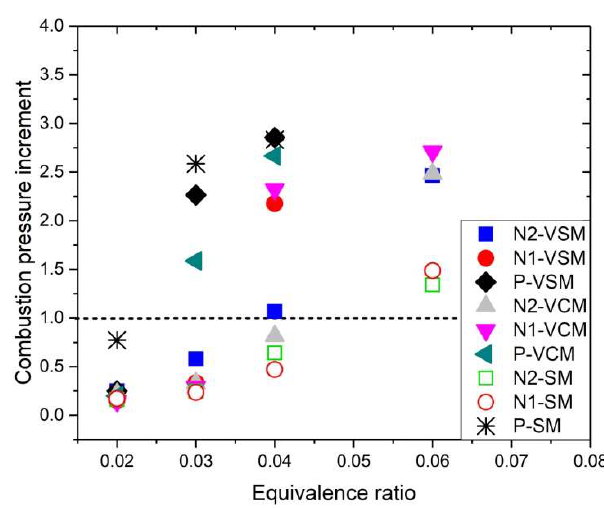
Figure 14. Combustion performance comparison: P—parallel injection, N1—normal 1 injection, N2—normal 2 injection, SM—step mixer, VSM—vent slot mixer, VCM—vent circle mixer.